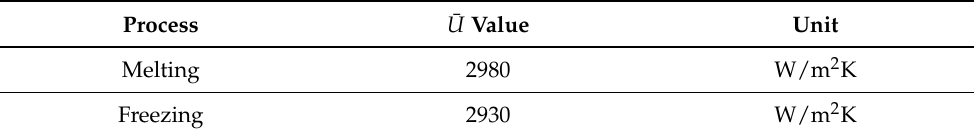
Table 7. Averaged Overall Heat Transfer Coefficient, ¯ U . Process ¯ U Value Unit Melting 2980 W/m 2 K Freezing 2930 W/m 2